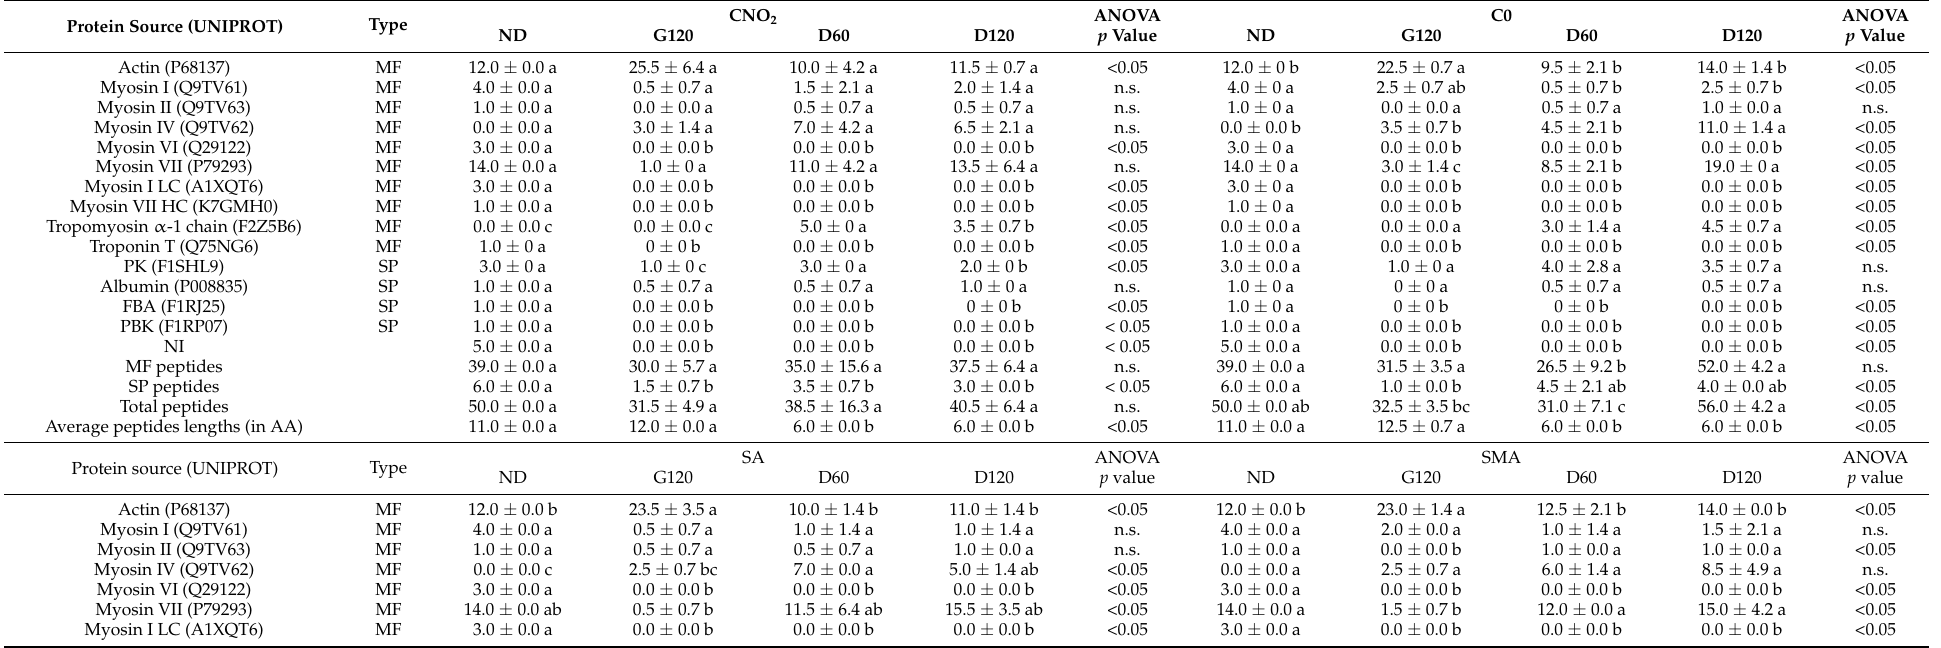
Table 2. Number of peptides in non-digested and digested salami at different digestion time. Data are means ± SD of non-digested or in vitro digestion of three independent samples analyzed in duplicate. Statistical analysis was performed a by one-way ANOVA with Tukey’s post-hoc test comparing each salami before digestion and at the three digestion times (different letters indicate significant differences). G120: end of gastric phase; D60: 60 min of duodenal phase; D120: end of duodenal phase. MF: myofibrillar; SP: sarcoplasmic; HC: heavy chain; LC: light chain; PK: pyruvate kinase; FBA: fructose bisphosphate aldolase; PBK: phosphorylase B kinase; NI: not identified; ND: not digested, AA: aminoacids; n.s.: not significant; C-NO 2 : salami with sodium nitrite, potassium nitrate and with nitrate-reducing microbial starter cultures; C-0: salami containing neither nitrate-reducing microbial starter cultures nor additives (nitrite, polyphenols and ascorbate); SA: salami with nitrate-reducing microbial starter cultures and sodium ascorbate; SMA: salami with nitrate-reducing microbial starter cultures, sodium ascorbate and plant